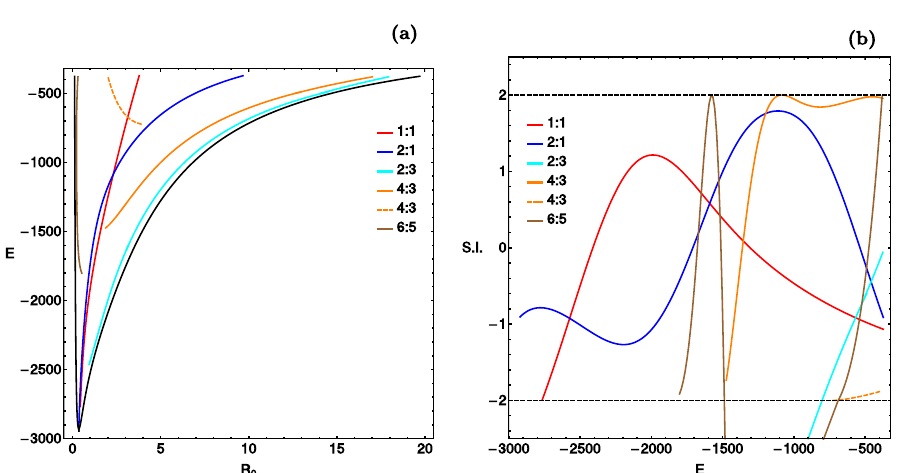
Fig. 1. Panel (a): the ( R 0 ; E ) characteristic curves of all the orbital families. Panel (b): the evolution of the stability index (S.I.) of all the families of periodic orbits shown in panel (a) as a function of the orbital energy E . The black horizontal dashed lines at –2 and +2 delimit the range of S.I. for which the periodic orbits are stable. & Carpintero (2013), where the ratio of these integers corresponds to the ratio